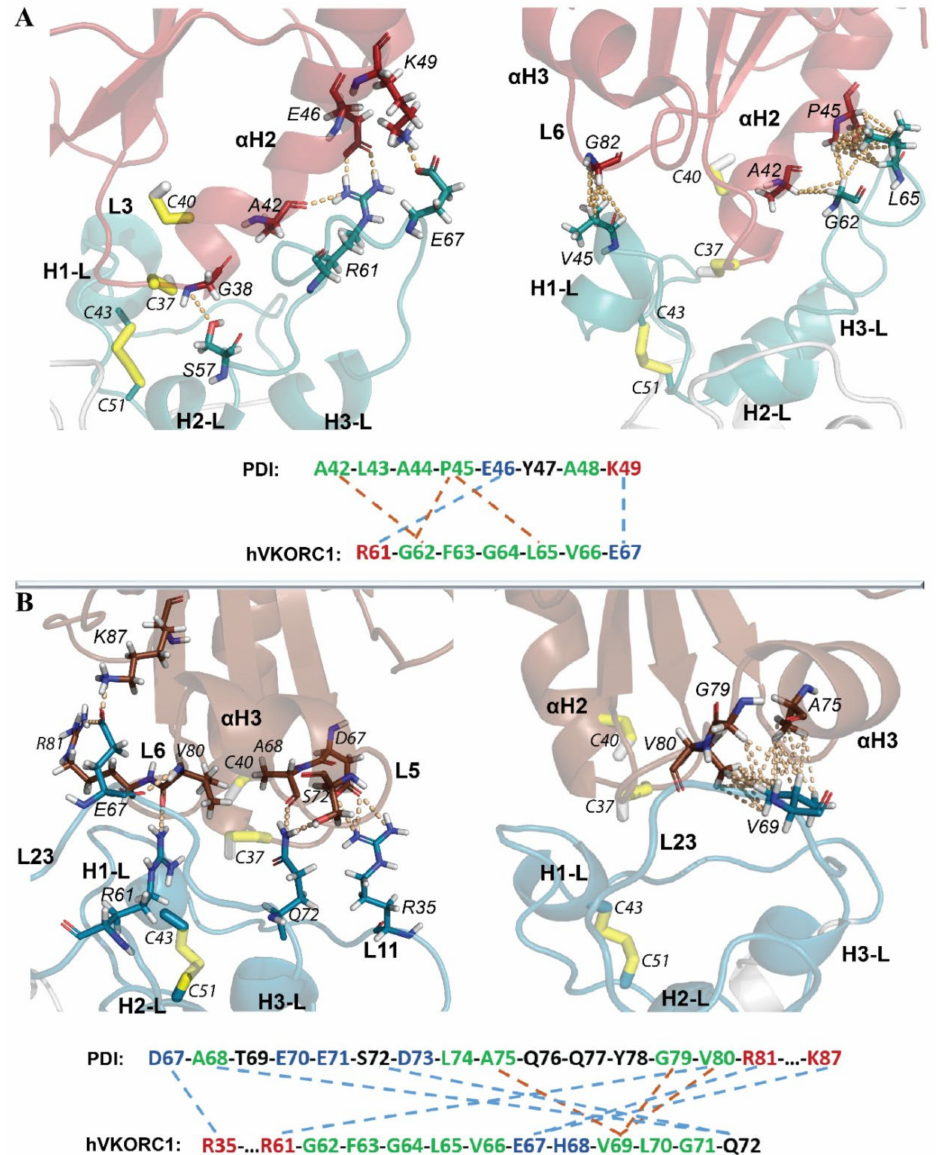
Figure 12. Intermolecular contacts at the interface between PDI and hVKORC1 in two models of the PDI–hVKORC1 complex. The intermolecular H-bonds and hydrophobic contacts between PDI and VKORC1 in Model 1 ( A , top) and Model 2 ( B , top). ( A , B ) The proteins are shown as coloured ribbons: PDI in red and brown and VKORC1 in cyan (L-loop), with the interacting residues and thiol groups as sticks. The contacts are indicated by dashed lines: H-bonds in yellow and hydrophobic contacts in salmon. The structural fragments and residues participating in the contacts are labelled. Analysis of the intermolecular contacts was performed on conformations taken at t = 80 ns. ( A , B ) A pattern of H-bond (in blue) and hydrophobic (in orange) contacts between the PDI and hVKORC1 residues (bottom). Residues are coloured according to their properties: the positively and negatively charged residues are in red and blue, respectively; the hydrophobic residues are in green; the polar and amphipathic residues are in